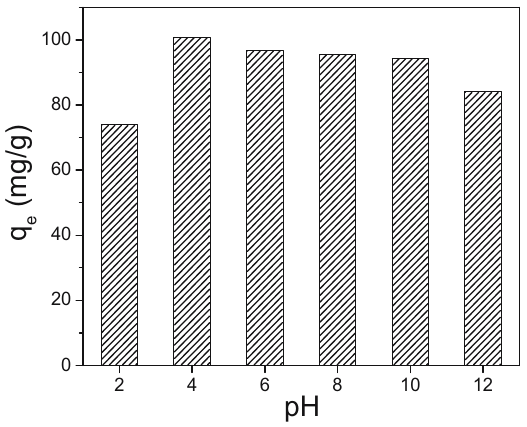
Figure 7: E ff ect of pH on the adsorption of SO 42− by the ET2.0.